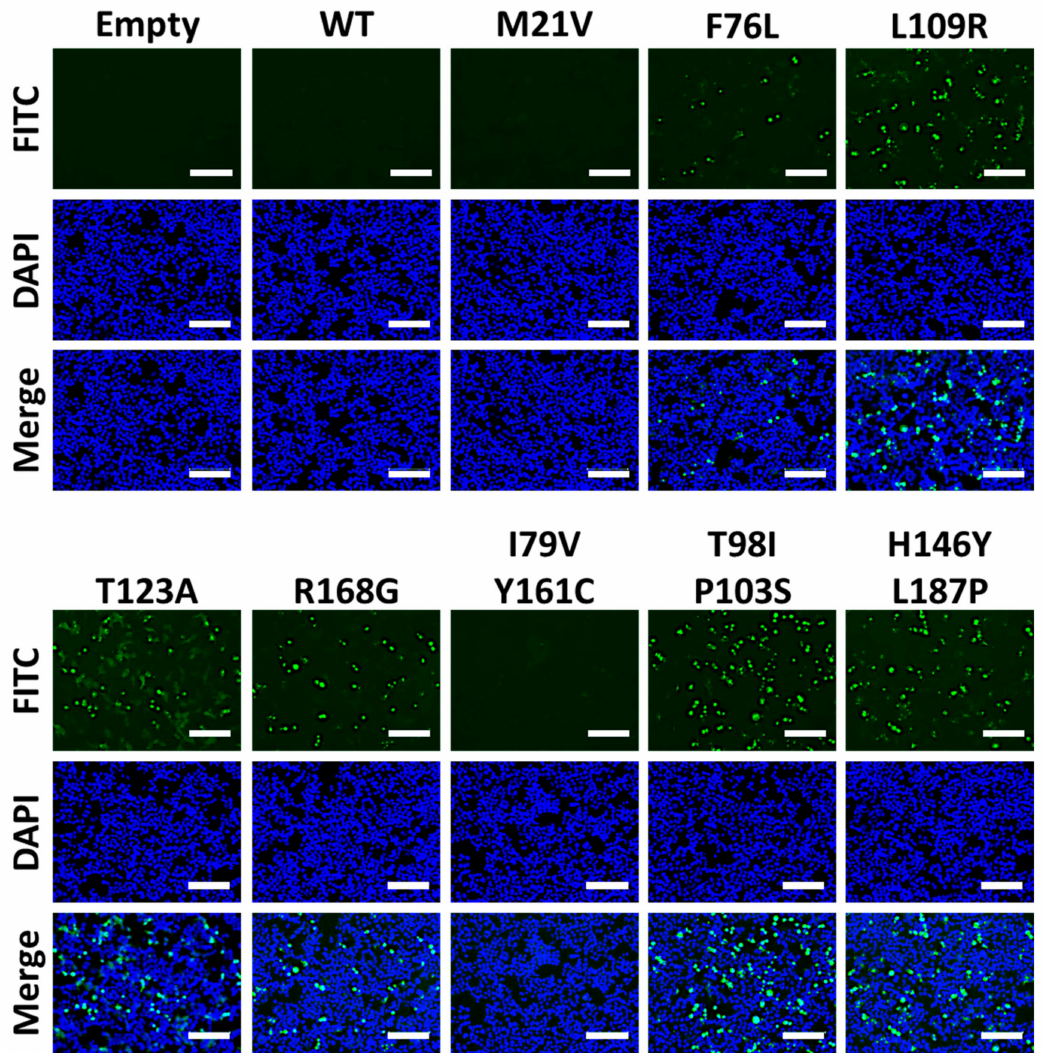
Figure 4. Effect of identified amino acid changes on the expression of PA-X: HEK293T cells were transfected with 1 µ g of pCAGGS 1918 PA-X HA-tagged WT or the indicated mutants. Empty pCAGGS transfected HEK293T cells were included as internal controls. At 24 h p.t., cells were fixed, permeabilized, and immunostained with a PAb against the HA epitope tag (green). DAPI was used to stain the nucleus of transfected cells (blue). Magnification 20 × , Scale bar = 100 µ